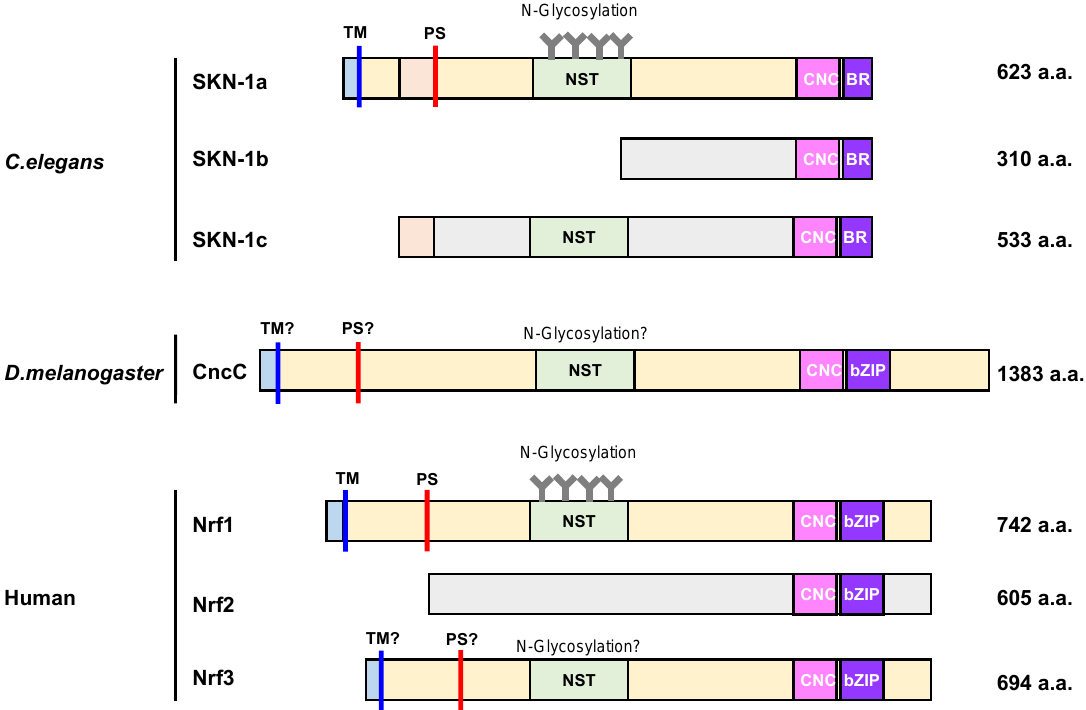
Figure 2. Domain organization of cap ‘n’ collar (CNC)-basic leucine zipper (bZIP) family proteins. The image depicts the domain organization of seven CNC-bZIP proteins, namely, SKN-1a, SKN-1b, SKN-1c, CncC, Nrf1, Nrf2, and Nrf3. CncC and Nrf proteins share a cap ‘n’ collar (CNC) and a basic leucine zipper (bZIP) domain in their C-terminus region, but SKN1 proteins only have a basic leucine domain (BR), which lacks the ZIP dimerization module. SKN-1a, CncC, Nrf1, and Nrf3 exhibit an N-terminal domain with a transmembrane (TM) region to anchor proteins to the ER membrane. Additionally, each of them, except for Nrf2, contain an Asn / Ser / Thr-rich (NST) domain, which is a target for N-glycosylation. The processing site (PS) is represented as red bars. To begin, the cytoplasmic region is colored in light blue, and the ER luminal region is colored in light yellow. C. elegans: